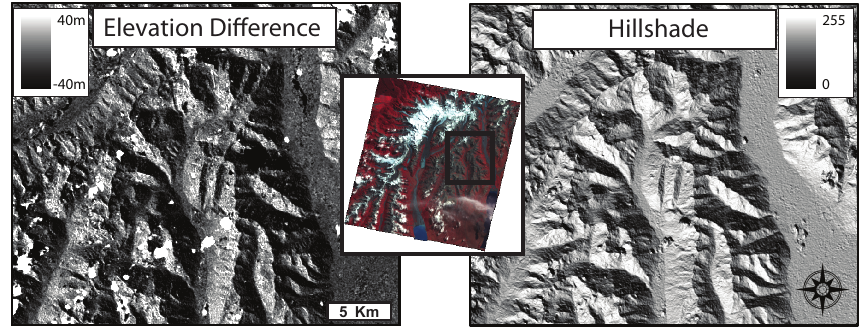
Fig. 1. The elevation differences before co-registration (left) between ASTER DEMs in 2006 and 2002 from New Zealand (described in Sect. 5.2 and shown in Fig. 5) are remarkably similar to the hillshade of the DEMs (right). The location of the subsetted region is depicted in the 2006 ASTER image (center).